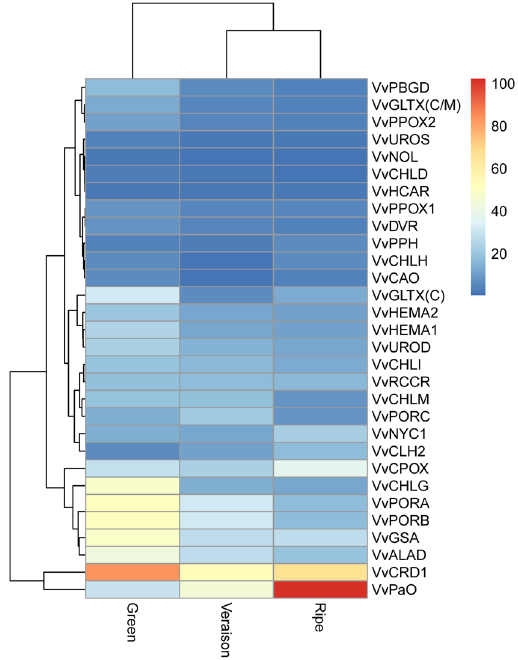
Figrue 8. Expression level of chlorophyll metabolism genes during grapevine ripening. Data were obtained by Illumina RNA Sequencing using two biological replicas and are expressed as Reads Per Kilobase of exon model per Million mapped reads